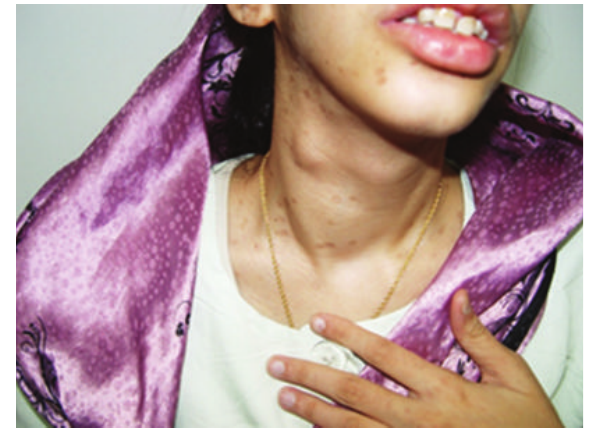
Figure 2: On physical examination, she had goiter with large nodule in the right lobe of her thyroid gland.